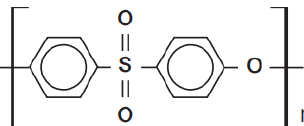
Figure 1. The membrane preparation solvent was N,N -Dimethylformamide P.A./ACS (DMF) from